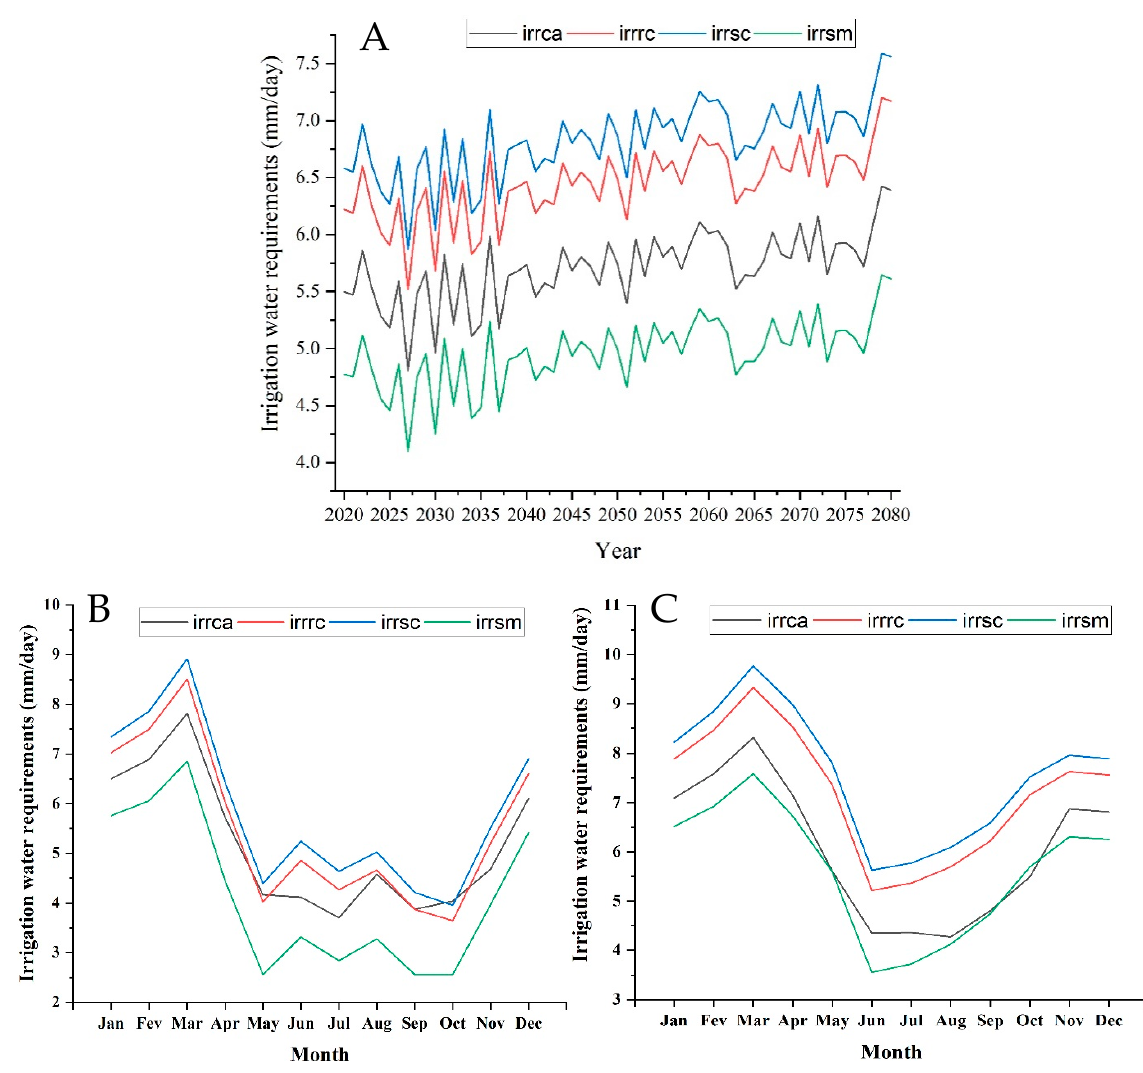
Figure 3. Evolution of irrigation water requirements (IWR) in mm/day under CSIRO RCP 4.5. ( A ) Demonstrates annual irrigation water requirements. ( B ) Demonstrates monthly irrigation water requirements for 2027, with the lowest irrigation water requirements by crops. ( C ) Demonstrates monthly irrigation water requirements for 2079, with the highest irrigation water requirements by crops. irrca denotes irrigation water requirement of cassava; irrrc denotes irrigation water requirement of rice and corn; irrsc denotes irrigation water requirement sugar cane; irrsm denotes irrigation water requirement